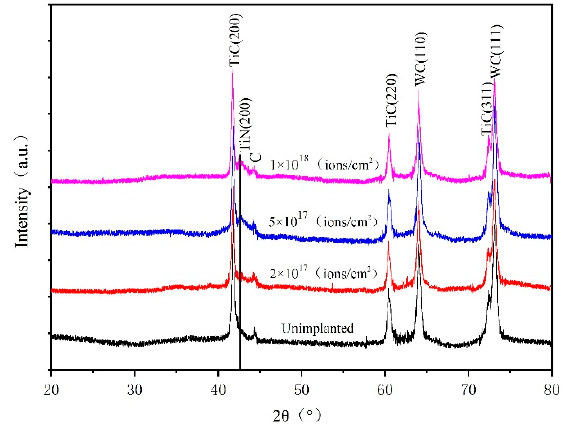
Figure 3. XRD patterns of TiC coatings implanted with different doses of N